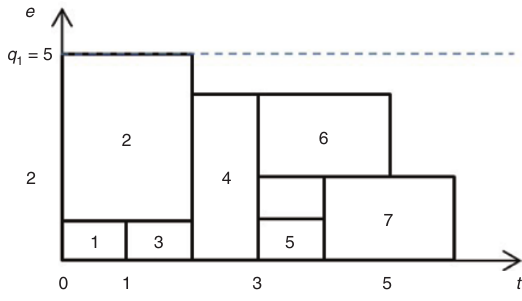
Figure 2: Example of